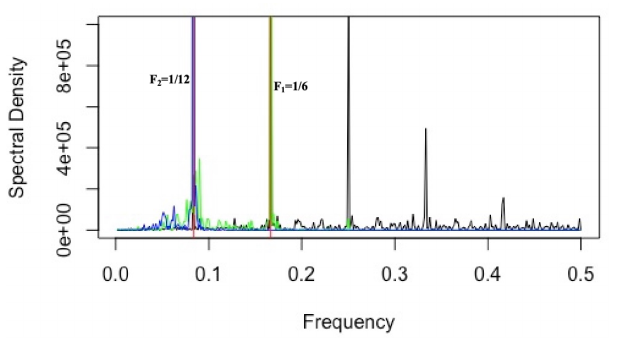
Figure 15. Trend obtained from the EEMD technique (black curve) with the trend of the original signal obtained from a moving window (blue curve) with a size of 144 months (i.e. 12